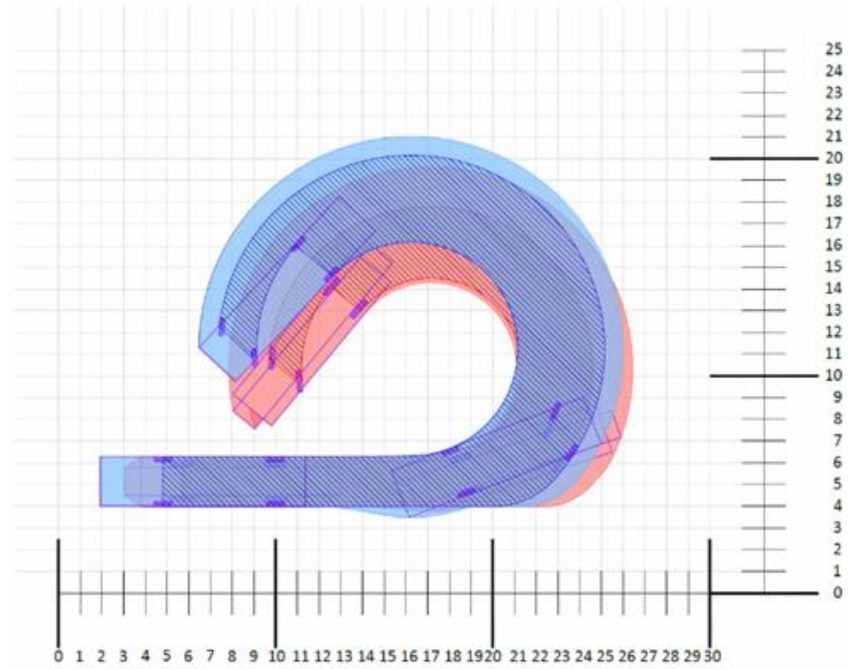
Figure 11. Swept paths of the fire engine ladder truck and garbage